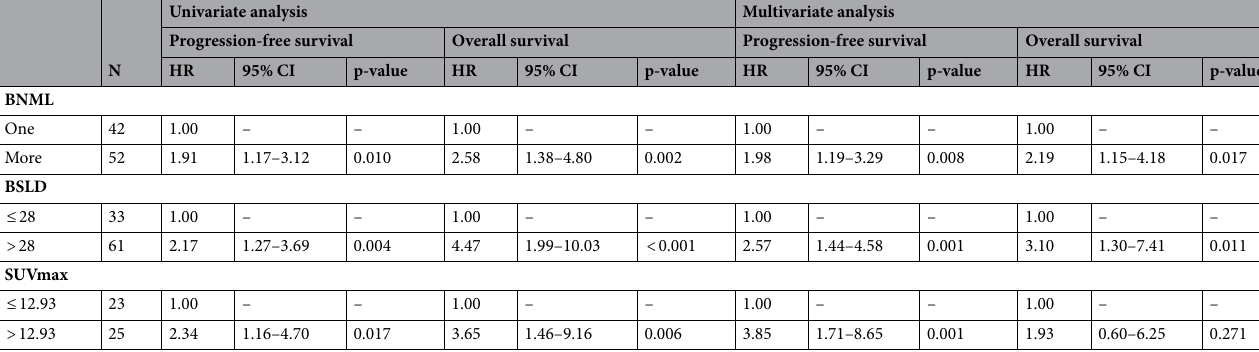
Table 2. The association between the tumor burden and clinical outcomes in patients with recurrent or metastatic head and neck cancer treated with immune checkpoint inhibitors. Adjusted by age, sex, Eastern Cooperative Oncology Group performance status. In analysis for overall survival, adjusted also by best overall response for anti-PD-1 monotherapy. HR hazard ratio, CI confidence interval, BNML the baseline number of metastatic lesions, BSLD the baseline sum of the longest diameters of the target lesions, SUV standardized uptake value.